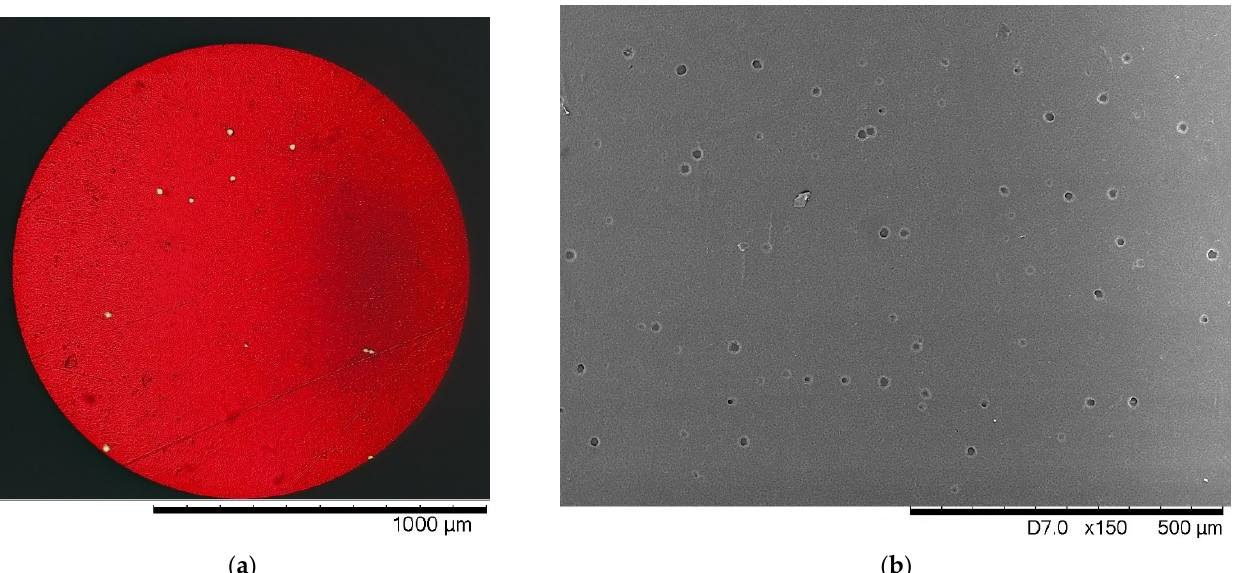
Figure 7. Examples of surface images of the detection film after chemical etching of latent tracks made using various microscopes: ( a ) optical microscope; ( b ) scanning electron microscope (differences in track diameters are clearly visible in the image) .